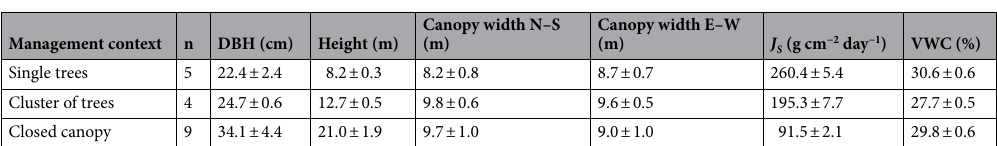
Relationships between sap flux and environmental drivers. Sap flux data were split into three 7-week time periods to investigate the seasonal variation of J S in response to soil moisture and VPD (Tables 2, 3). Linear regression was used to determine the association between the independent variable (soil moisture or VPD) and dependent variable ( J S ). J S was not significantly related to soil moisture, except early and late summer at the single tree and closed canopy sites (Table 3). However, based on the R 2 values of these relationships, soil moisture explains very little of the variability of J S (R 2 values between 0.001 and 0.17, Table 3). Repeated measures ANOVA of the J S -VPD regression parameters showed that the slope and intercept were significantly different between single and closed canopy sites across all time periods (Table 2, Fig. 4). The slope